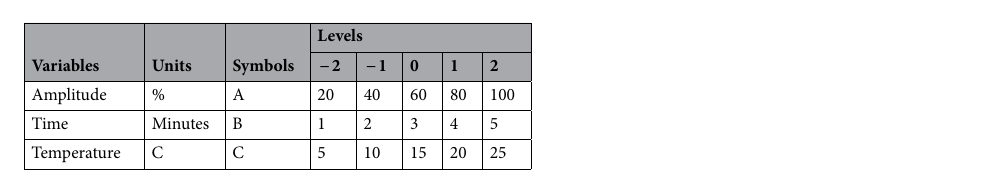
Table 1. Experimental range and levels of